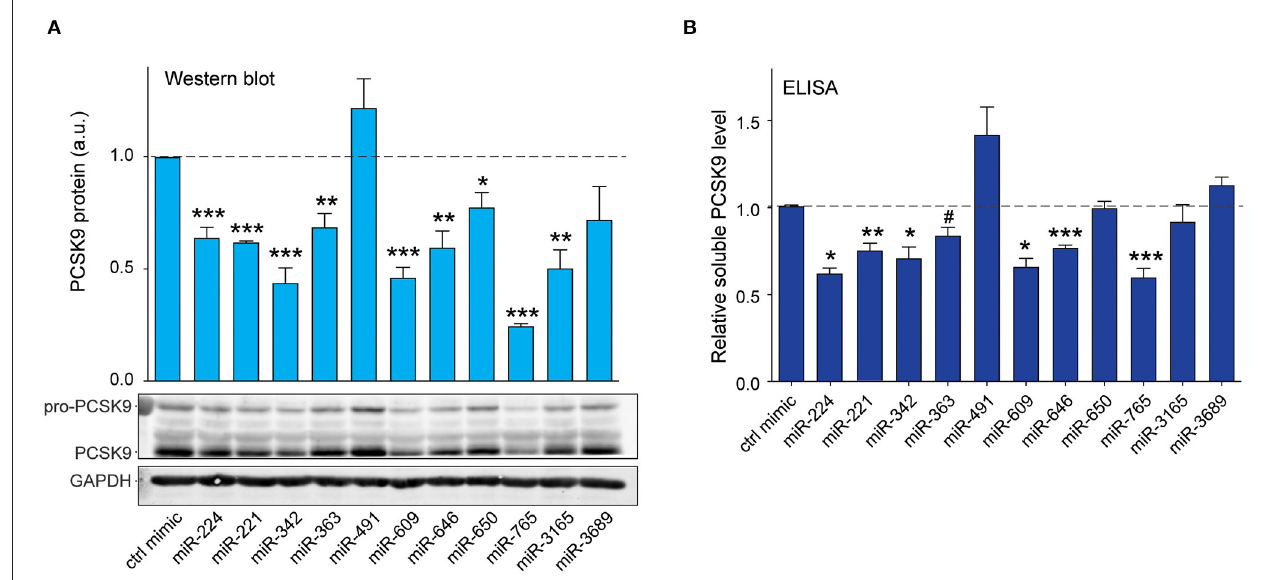
FIGURE 4 | Validation of top 10 candidate miRNAs targeting human PCSK9. (A) Western blotting analysis of PCSK9 and GAPDH protein in HepG2 cells transfected with miRNA mimics or a control mimic. Relative quantification of three independent experiments is shown above the blots. (B) ELISA quantification of secreted PCSK9 in supernatants derived from HepG2 cells transfected with miRNA mimics or a control mimic. (A,B) Data are the mean ± standard error of the mean from three independent experiments. p -Values were calculated using two-tailed Student’s t -test. # p < 0.1, * p < 0.05, ** p < 0.01, *** p <